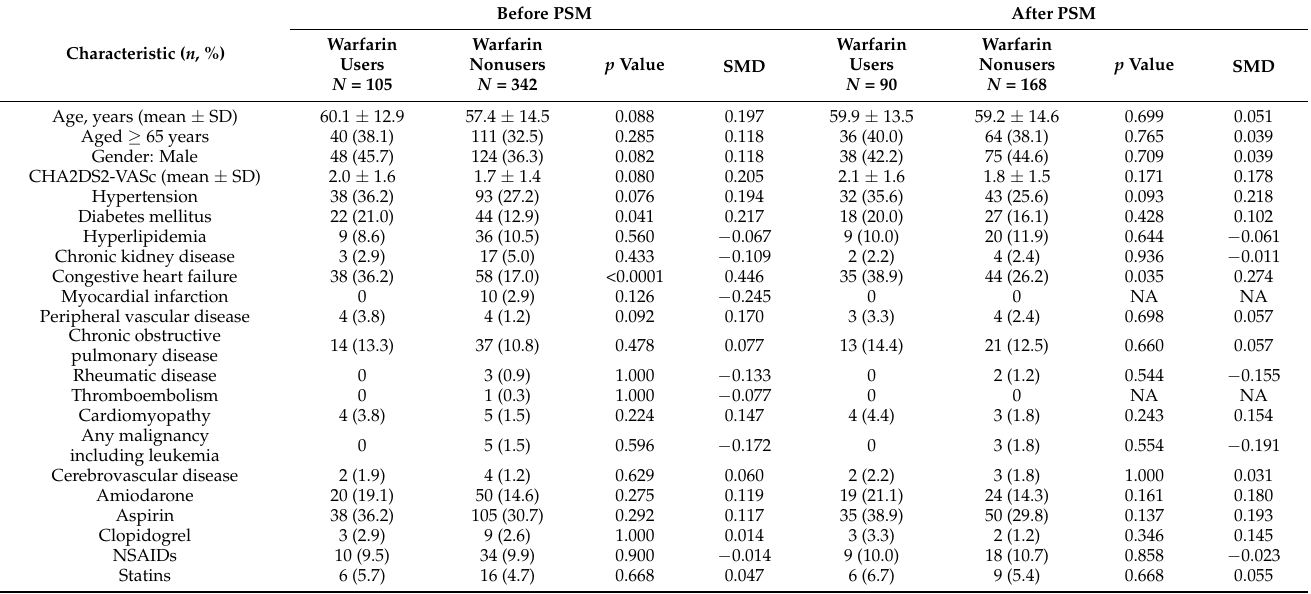
Table 1. Baseline characteristics of the study